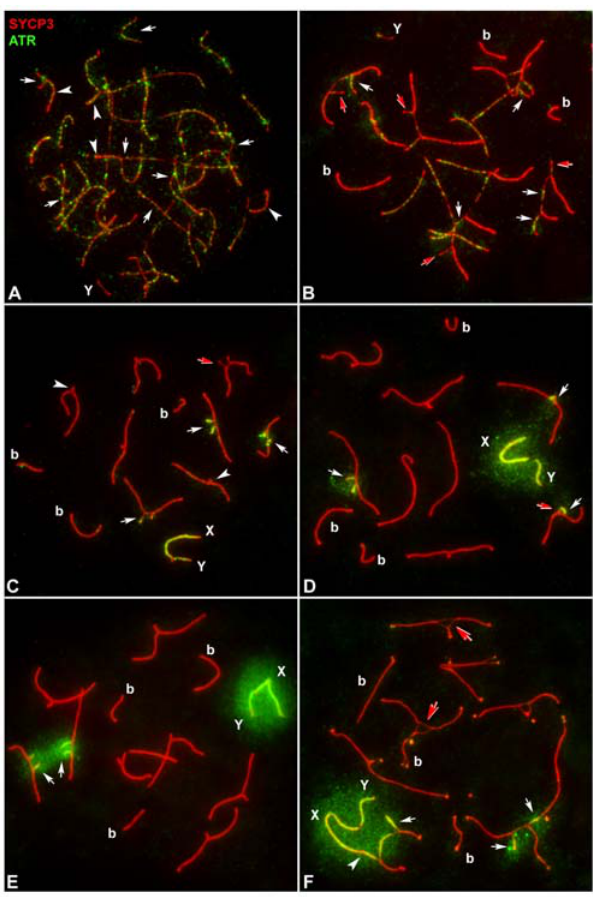
Figure 3. Localization of c H2AX (red) and SYCP3 (green) during prophase-I. c H2AX signal has been under-exposed to show its localization in unsynapsed regions. Inserts represent c H2AX labeling of selected bivalents and trivalents at a normal bright level. (A) Leptotene. c H2AX is distributed throughout the whole chromatin. (B) Zygotene. c H2AX is present in the X chromosome (X) and regions that are still unsynapsed (arrows), but fades in synapsed regions (arrowhead) of bivalents (b) and trivalents and is undetectable in the Y chromosome (Y). (C,D) Early Pachytene. c H2AX occupies a wide area in the chromatin surrounding the unsynapsed AEs of X, Y and autosomes (white arrows), but also localizes in the chromatin close to the SC in synapsed regions in both bivalents and trivalents. Some unsynapsed regions of trivalents do not present c H2AX signal (red arrows). Arrowheads marks ectopic synapsis between trivalents and between a trivalent and the X chromosome. Sex chromosomes lie apart from each other in (C) but have synapsed in (D). Notice that in the selected trivalent shown in (D) both acrocentrics are unsynapsed near the proximal region, but one of them shows an intense c H2AX labeling (white arrow) while the other lacks labeling (red arrow) (see insert). (E) Late pachytene. c H2AX is restricted to the chromatin surrounding the unsynapsed AEs of XY chromosomes and open trivalents (white arrows). Ectopic association is found between one acrocentric chromosome and the X chromosome (arrowhead). Red arrows mark the absence of c H2AX in synapsed heterologous regions of closed trivalents. (F) Diplotene. c H2AX labeling is present in two trivalents and the sex chromosomes. Labeled trivalents show two different regions: The chromatin proximal to the centromeres is labeled in both the acrocentric and the metacentric chromosomes (red arrows) while more distal regions are unlabelled (white arrows). In unlabelled trivalents, the proximal regions of acrocentrics often appear associated (arrowheads). doi:10.1371/journal.pgen.1000625.g003 cytes progressed to late pachytene (Figure 4E). During diplotene, ATR remained visible on the surrounding chromatin of the sex chromosomes and of the open trivalents (Figure 4F); its signal